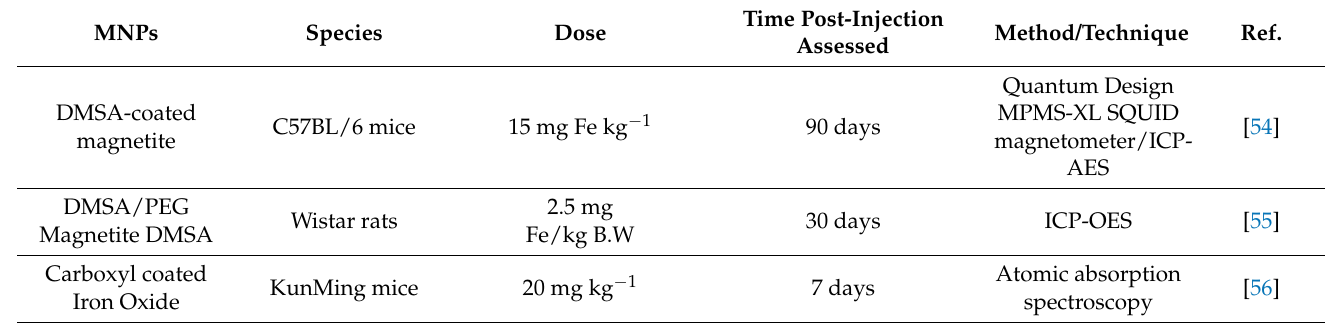
Table 1. Studies employed on assessment of the MNPs long-term